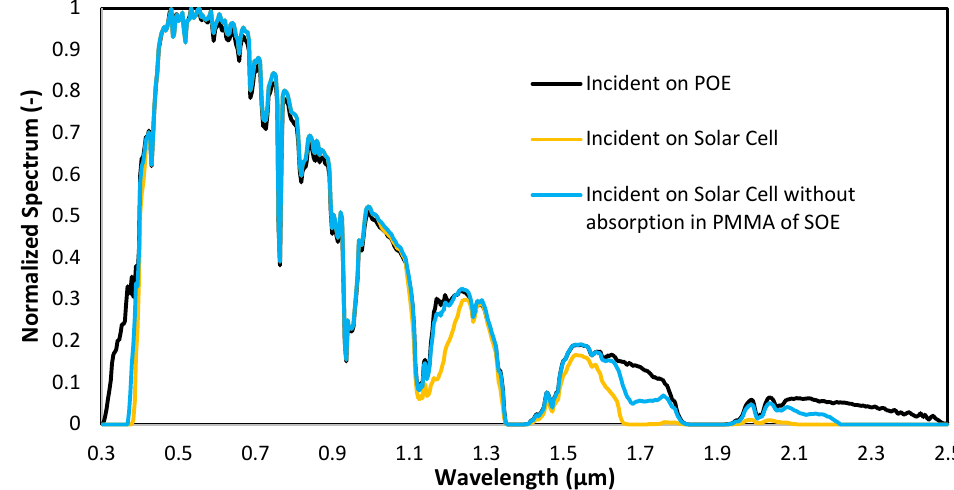
Figure 6. Incident normalized spectral distributions over the POE (black line), and over the solar cell in two different cases: ( a ) (blue line) without any light absorption inside the PMMA of the SOE; and ( b ) (yellow line) considering the light absorption in the PMMA of the SOE.